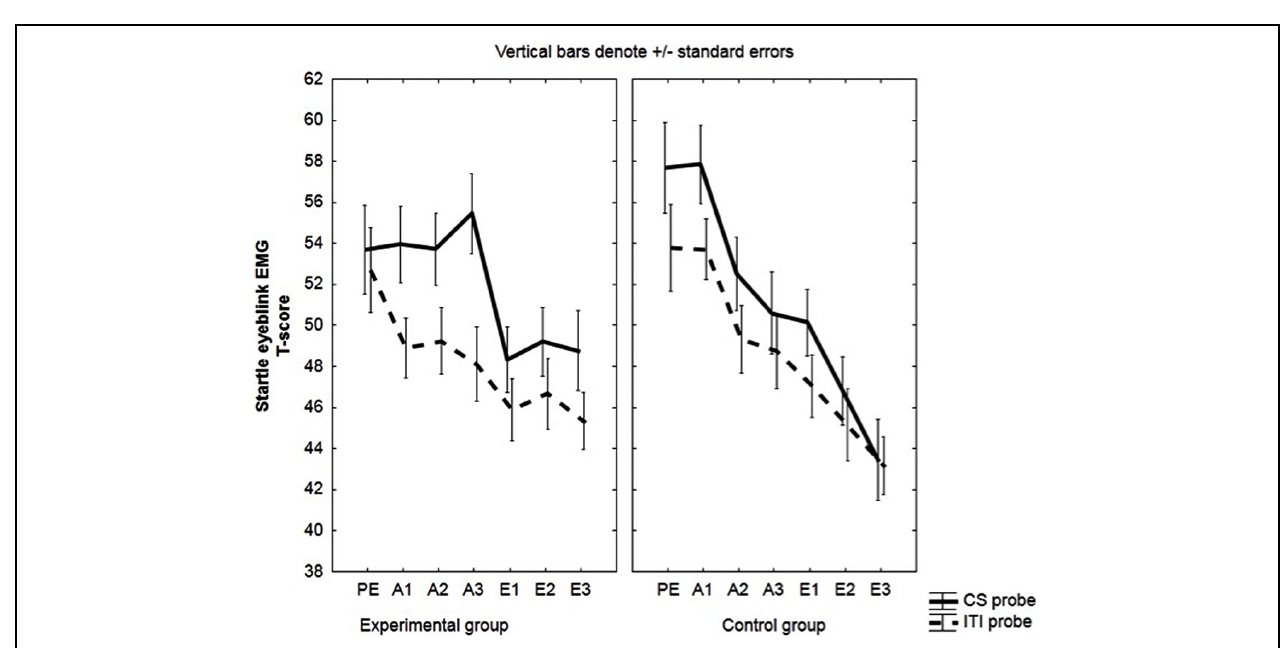
(certainly breathing resistance) for the experimental and the control group. Responses were averaged across three pre-exposure trials (PE), two acquisition trials (A1, A2, A3) and two extinction trials (E1, E2, E3).